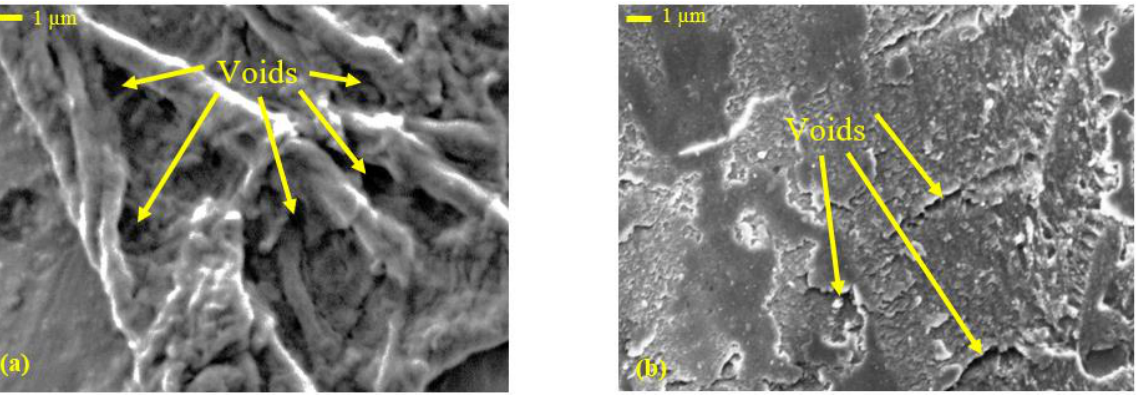
Figure 13. SEM micrographs of the compressive fractured surface of ( a ) PLA and ( b )